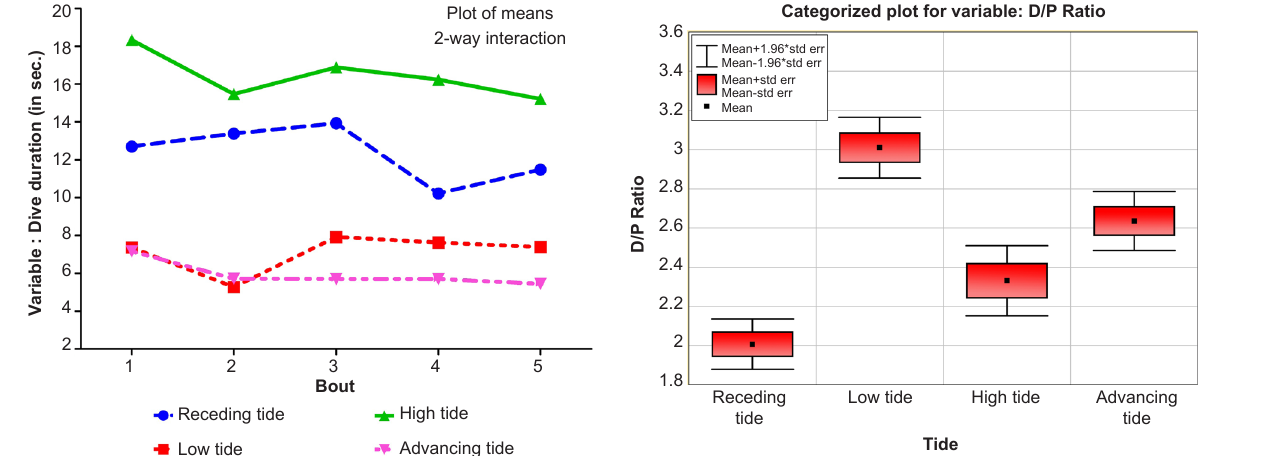
Categorized plot for variable: D/P Ratio